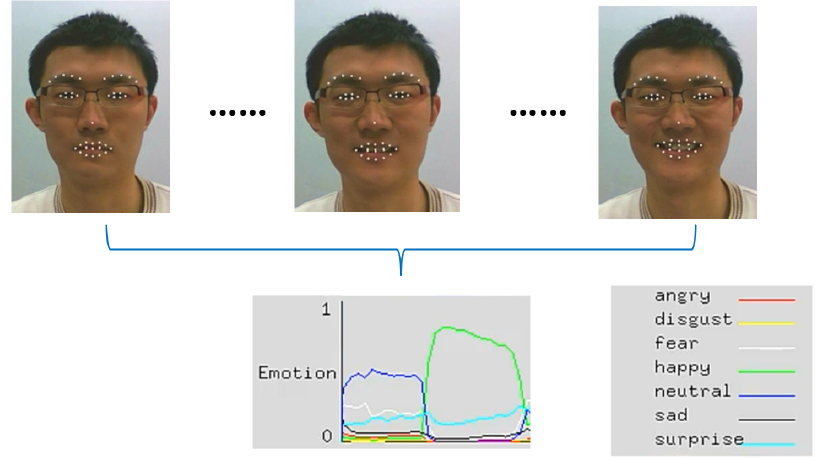
Figure 8. Recognition rates of emotion types as a function of frame index (time) in a video sequence.